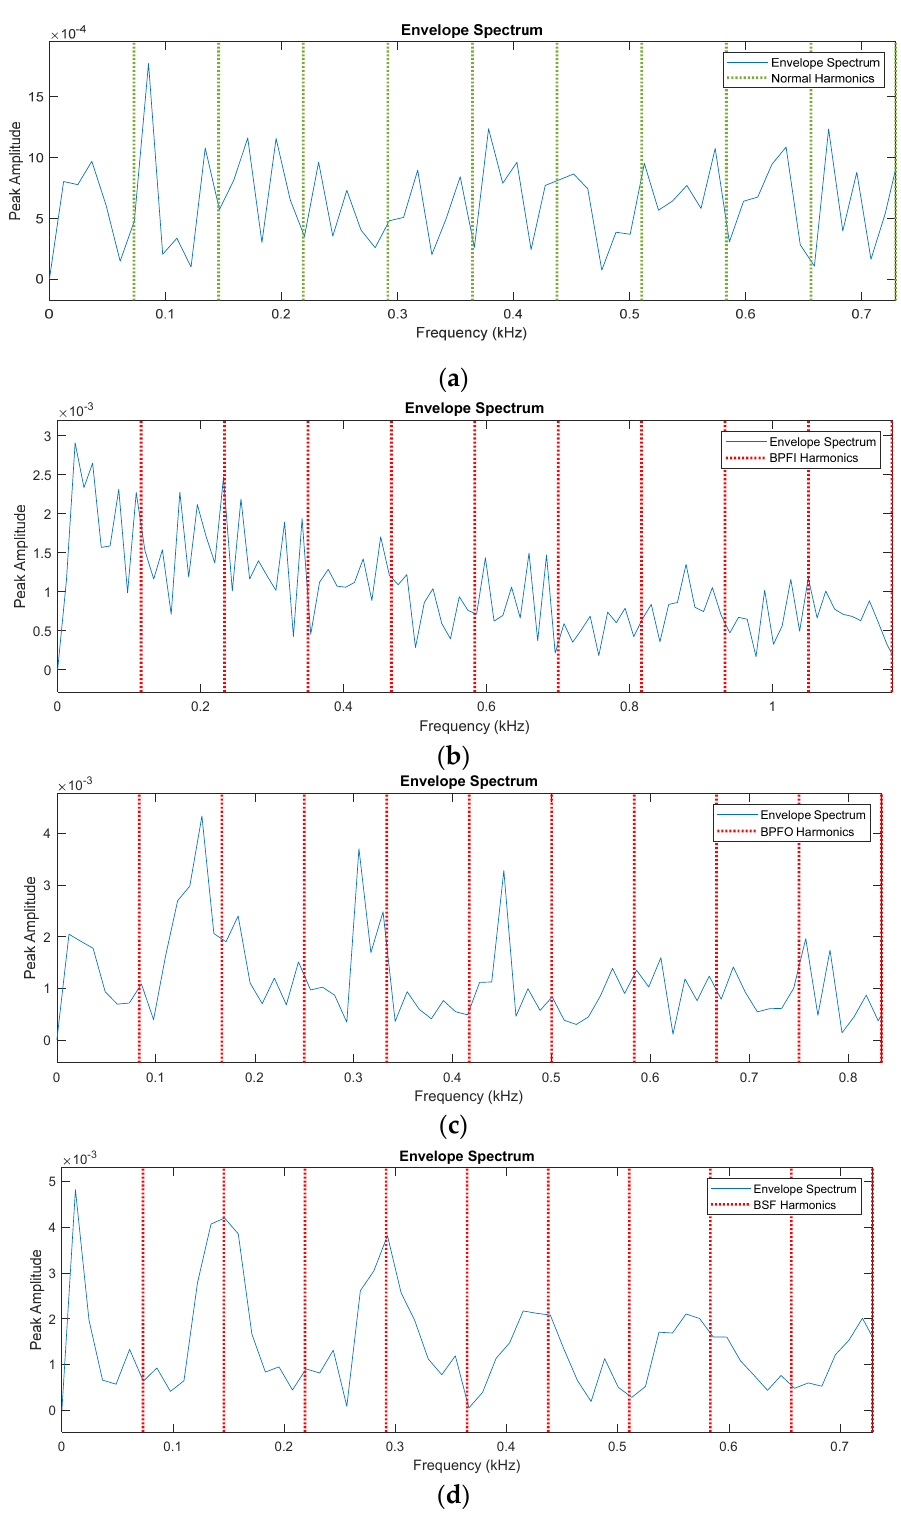
Figure 6. Envelope–spectrum for different bearing operating condition: ( a ) normal, ( b ) inner race fault, ( c ) outer race fault, ( d ) ball race fault.